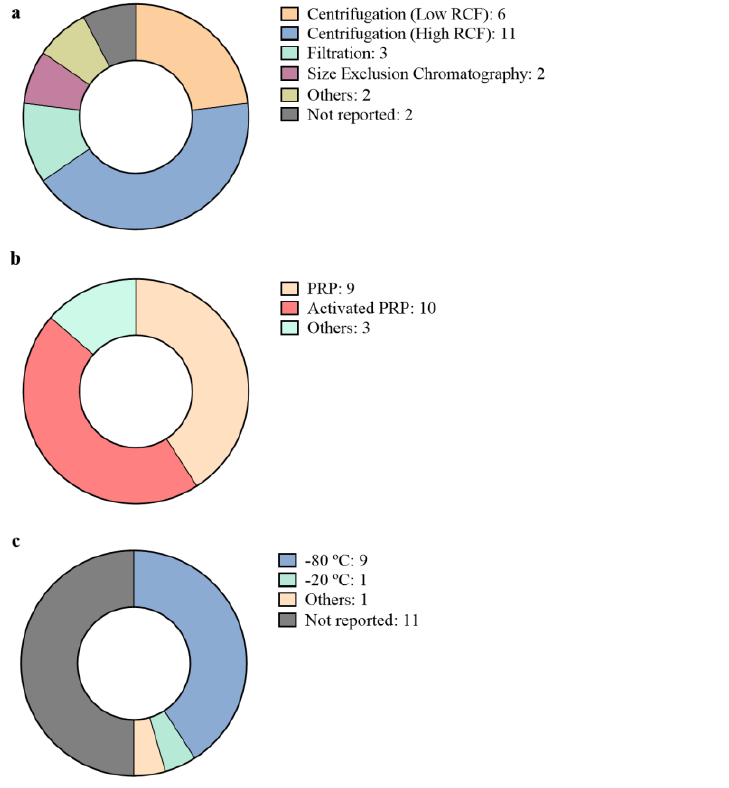
Figure 2. pEVs isolation methods reported for regenerative approaches. ( a ) Diagram shows the proportion and the number of reports that used centrifugation at low relative centrifugal force (RCF; lower than 80,000× g ), centrifugation at high RCF (higher than 80,000× g ), filtration, size exclusion chromatography, other methods or did not report the isolation method used. If two different methods or a combination of methods was used, both groups are represented on the diagram. ( b ) Diagram represents the platelet source used for pEVs isolation, whether it was platelet rich plasma (PRP), activated PRP or other platelet sources. ( c ) Diagram shows the storage conditions of the isolated pEVs before use. Temperature conditions at − 80 °C, − 20 °C, others or not reported conditions are also represented on the figure. A total of 22 articles were reviewed to obtain this data.